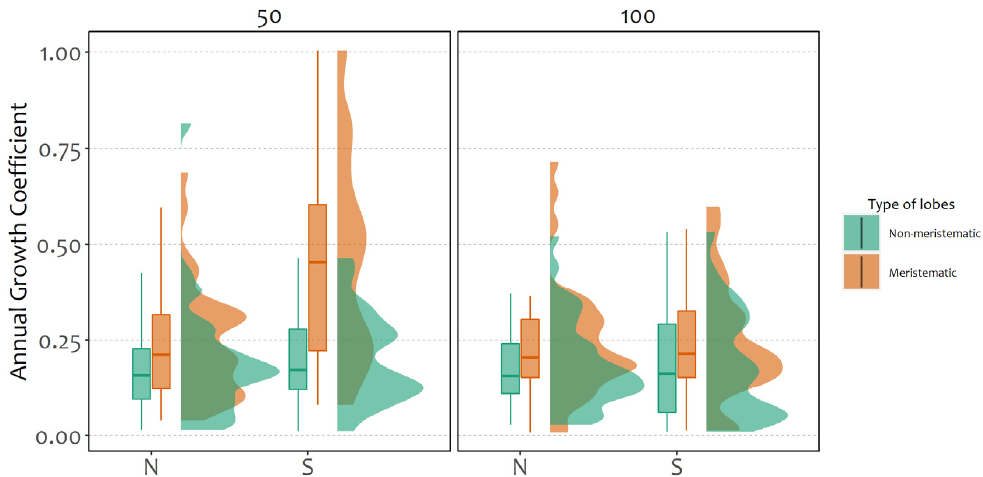
Figure 3. Annual growth coefficient in the unlogged stand according to type of lobes (meristematic and non-meristematic), aspect and different heights from the ground (50 and 100 cm).